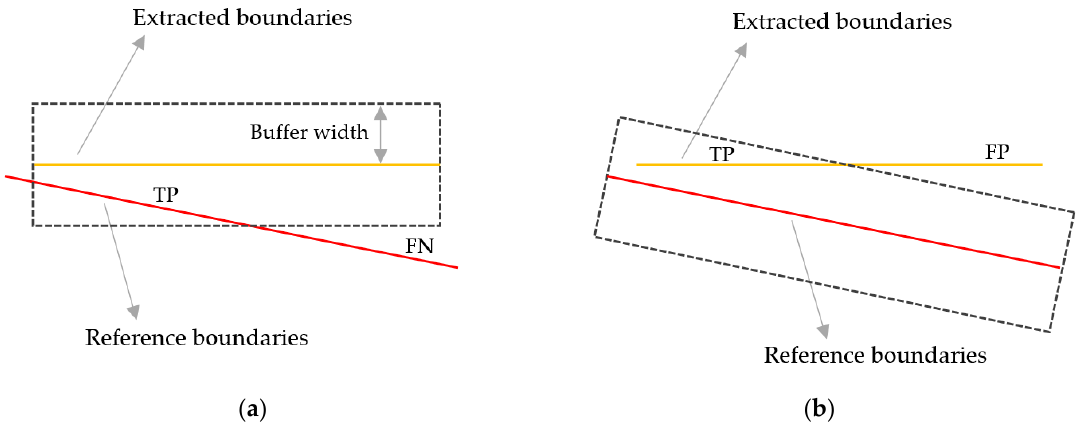
Figure 3. Object-based accuracy assessment method — buffer overlaying method. ( a ) Matched reference. ( b ) Matched extraction. ( a , b ) Calculation of boundary lengths of true positives (TP), false positives (FP) and false negatives (FN) (Adapted from [50]).